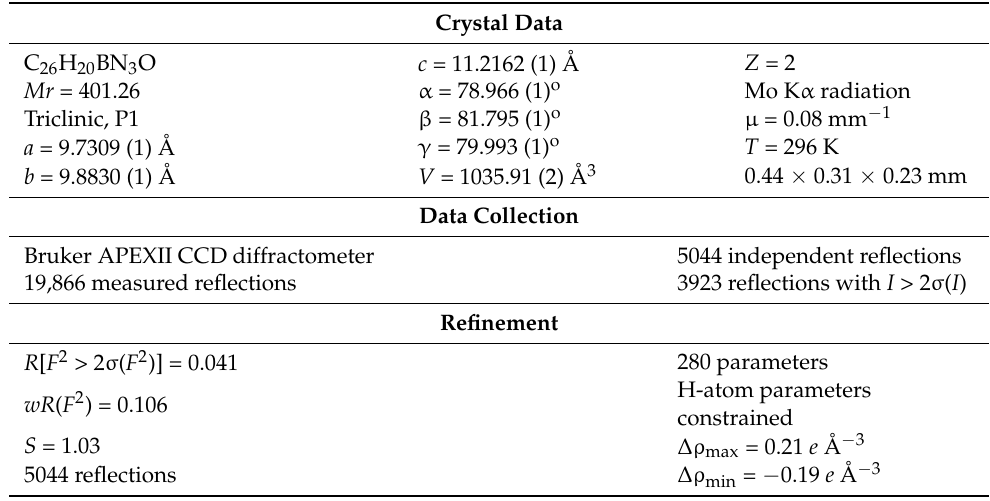
Table 3. Crystallographic data of 2c .